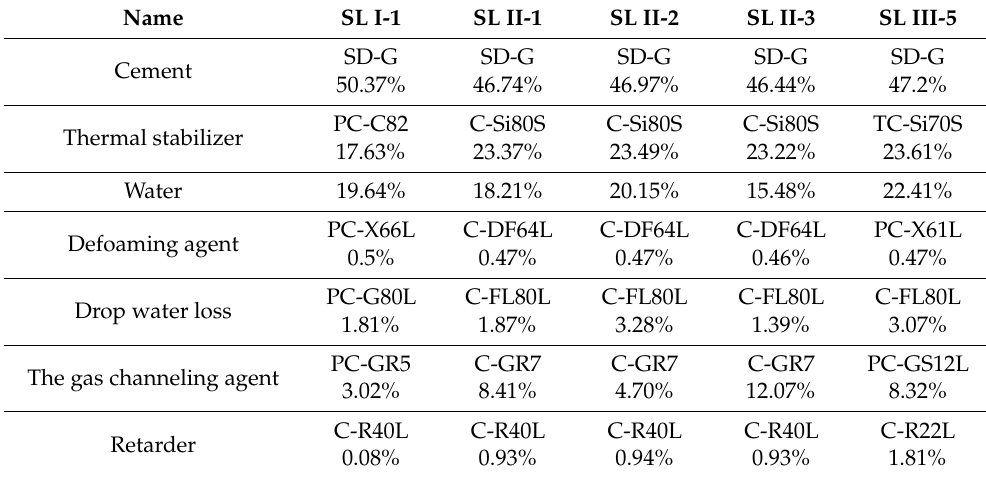
Table 1. Formulation system table of dual-deep well cement slurry.